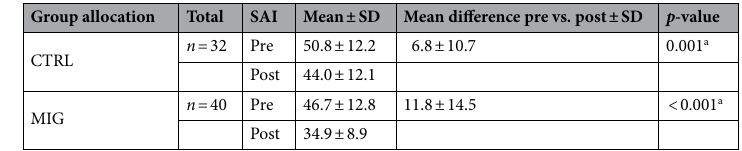
Table 3. Patients’ pre- and post-interventional anxiety levels according to each study group. a paired-samples t-test (pre- and post-interventional SAI). CTRL control group; MIG music intervention group; SAI state anxiety inventories; SD standard deviation.